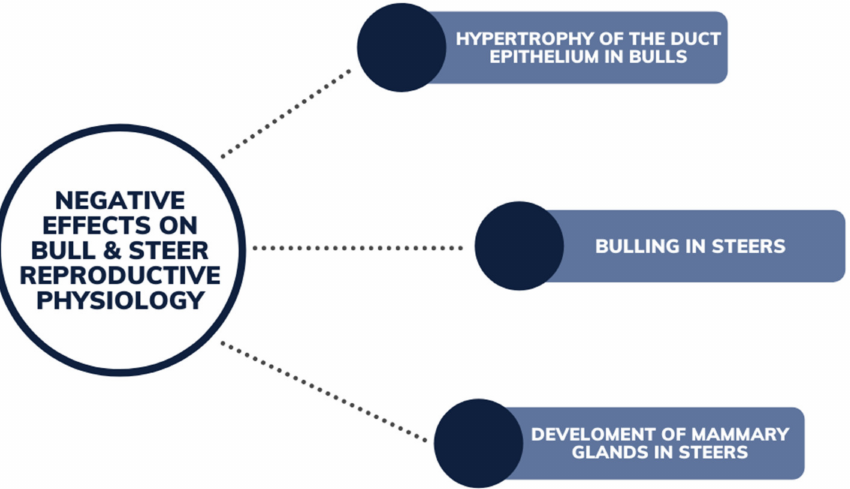
Figure 9. Negative effects of phytoestrogens on bull and steer reproductive physiology from grazing legume